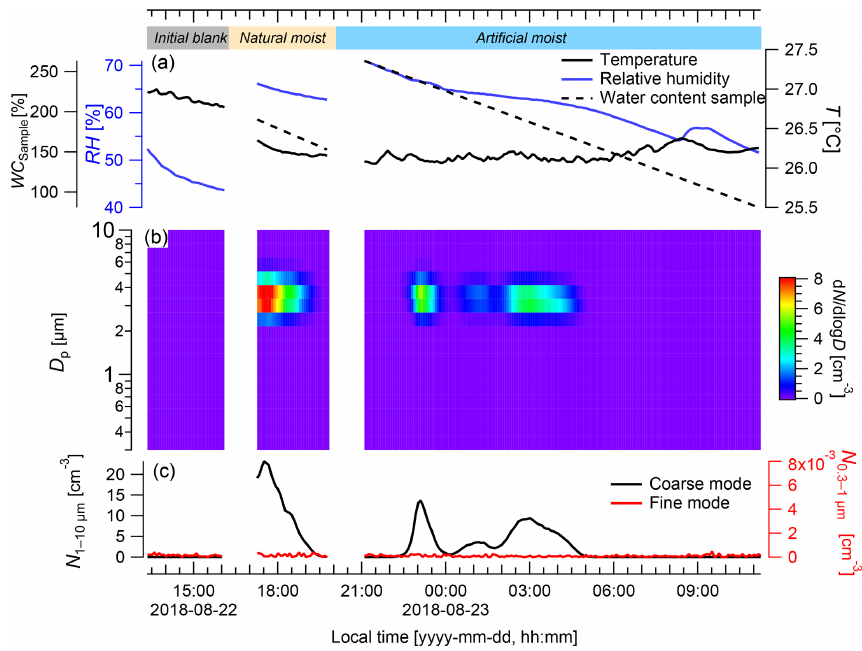
Figure 6. Particle emission patterns of Rigidoporus microporus measured under lab conditions. (a) Temperature ( T ) and relative humidity (RH) measured inside the cuvette, and the gravimetrically determined water content of the sample (WC sample ); (b) the concentration of different particle size classes over time; and (c) the number of the particles ranging from 0.3 to 1µm (fine mode) and from 1 to 10µm in diameter (coarse mode). In the beginning and at the end of the measurement, a blank measurement was conducted with an empty cuvette (see labeling in panel (a) ; final blank not shown for brevity). After the initial blank, the sample was first measured with its natural water content (natural moisture) and then after spraying with water (artificial moisture). When the cuvette was opened for the insertion and removal of the sample, particles from outside caused a short increase in particles (measurement artifact), which was removed. Data are presented as 5min